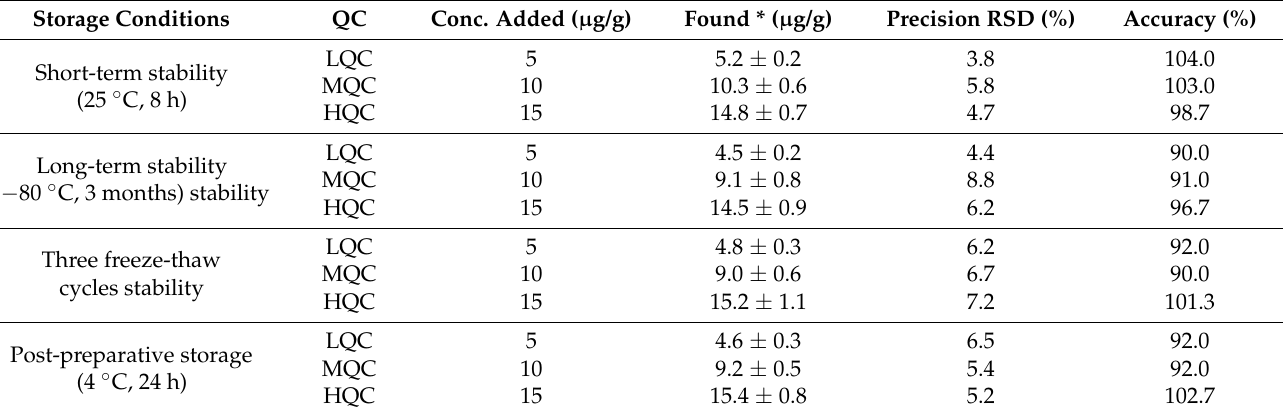
Table 4. Stability of DOX in rat liver tissue samples under various conditions (mean ± SD, n =